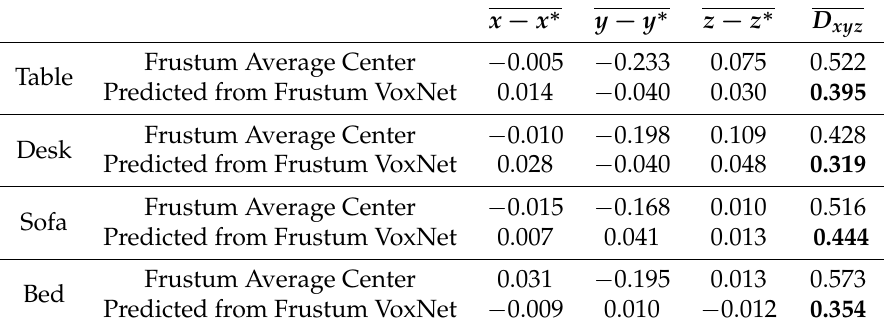
Table 7. Result comparison between average and predicted center from Frustum VoxNet.